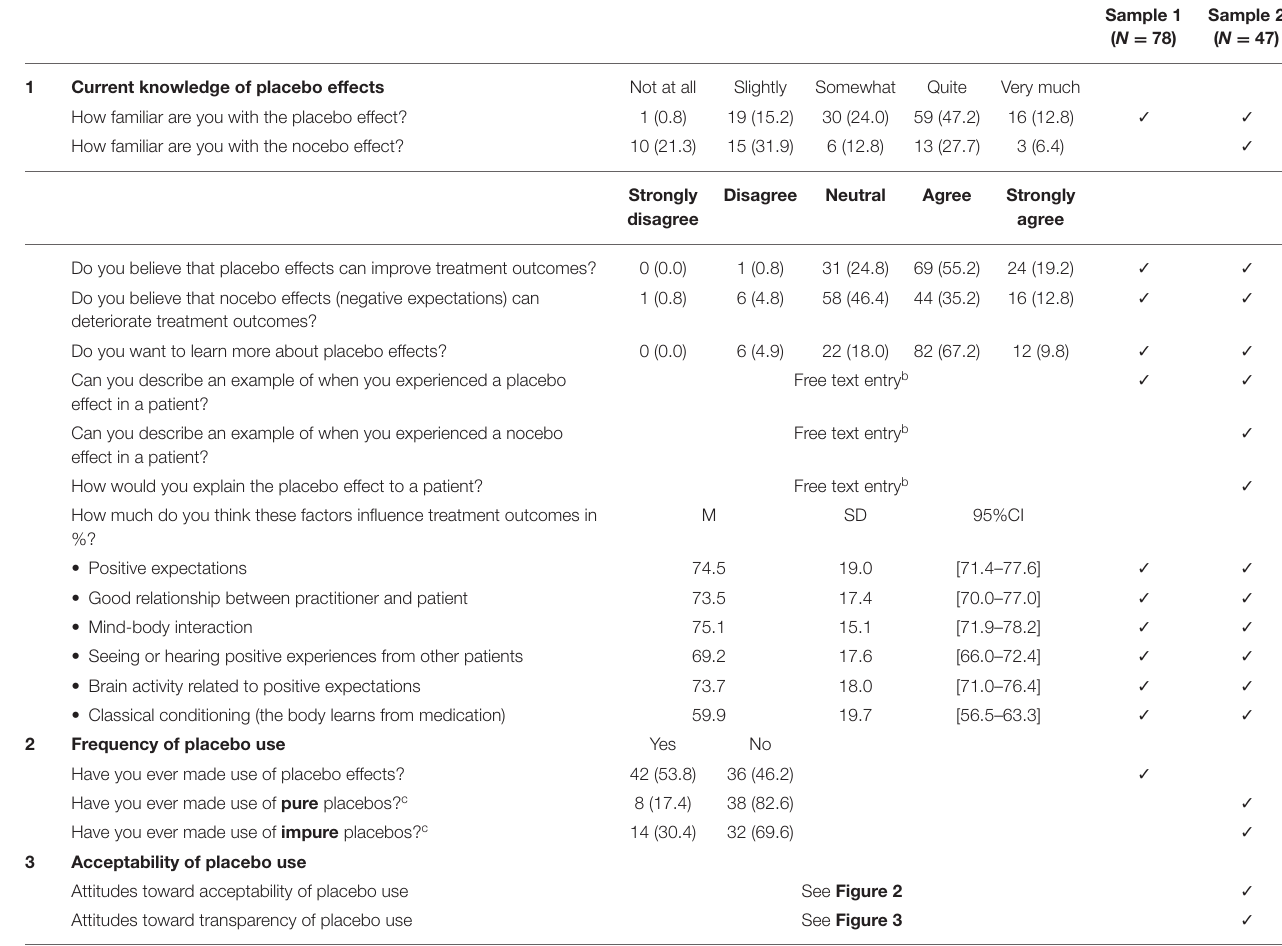
TABLE 2 | Overview and results of survey questions ( N =